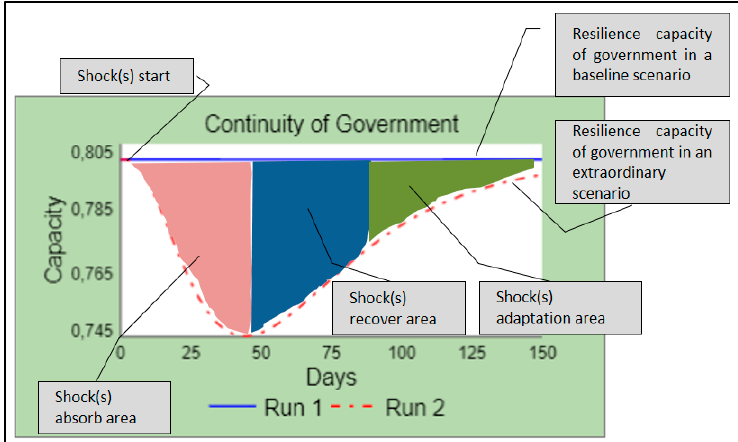
Figure 7. Sample output graph of continuity of government baseline requirements for baseline and extraordinary scenarios.